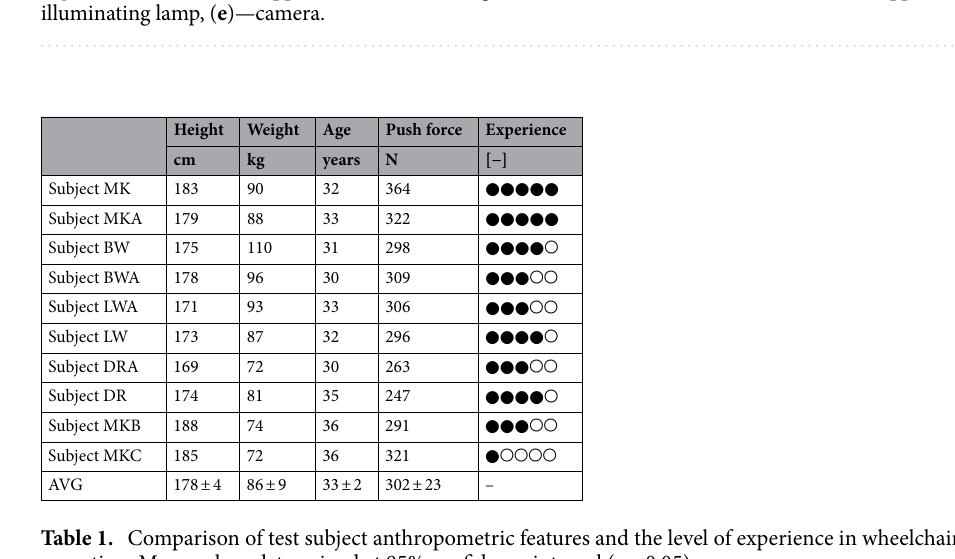
Figure 3. Measurement apparatus used for testing: ( a )—AruCo marker, ( b )—arm, ( c )—EMG apparatus, ( d )— illuminating lamp, ( e )—camera.